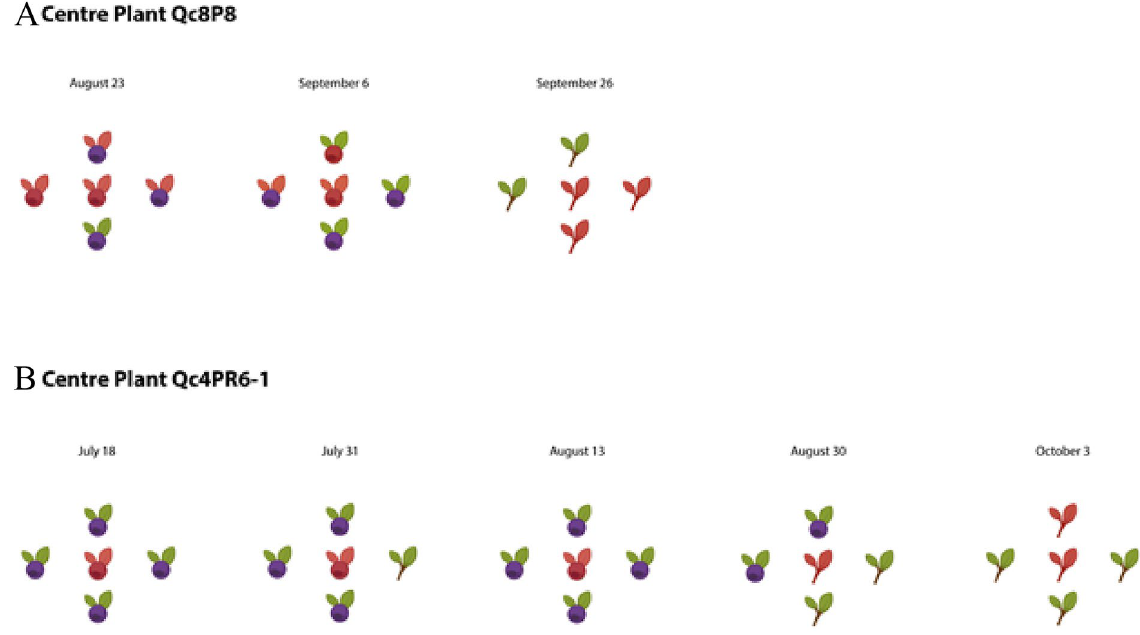
Figure 6. Outcome of LAMP tests on samples taken on a highbush blueberry plant and four nearby highbush blueberry plants in 2018. The plants were 1.5 and 2 m distant respectively on the row (vertically) and between rows (horizontally). ( A ) Centre plant = Qc8-P8. All plants were of cultivar Bluecrop. ( B ) Centre plant Qc4-PR6-1 was known to be phytoplasma positive since 2016. All plants were of cultivar Blueray. Legend: red root (+); green root (−); red fruit (+); blue fruit (−); red leaf (+); green leaf (−). Gray tissues (roots, fruit, leaves) were not tested. See Plate 1 for selected